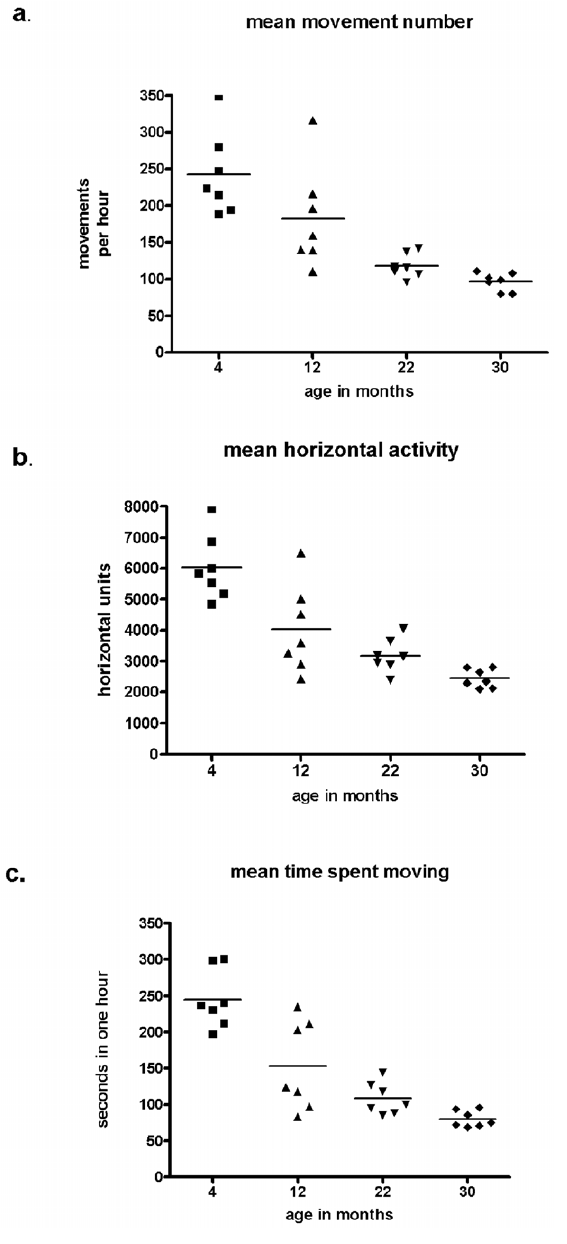
Figure 4. Longitudinal-characterization of locomotor activity during aging. Mean for the age tested represented by horizontal line and the locomotor activities of test subjects represented by points. The young group was tested at 4 and 12 months and the old group tested at 22 and 30 months. a. movement number (ANOVA, group p , 0.0001; post-hoc 12 vs. 30 mos, p , 0.05): aging difference within group, 4 vs. 12 mos., p , 0.05; 22 vs. 30 mos., p , 0.05 (Student’s paired t-test used for all within group comparisons). b. horizontal activity (ANOVA, group p , 0.0001; post-hoc 12 vs. 30 mos., p , 0.01): aging difference within group, 4 vs. 12 mos., p , 0.05; 22 vs. 30 mos., p , 0.05. c. time spent moving (ANOVA, group p , 0.0001; post-hoc 12 vs. 30 mos., p , 0.05): aging difference within group, 4 vs. 12 mos., p , 0.05; 22 vs. 30 mos., p , 0.05. Data not shown : total distance (ANOVA, group p , 0.0001; post-hoc 12 vs. 30 mos, p , 0.05): age difference within group, 4 vs. 12 mos., p , 0.05; 22 vs. 30 mos., p . 0.05, and movement velocity (ANOVA, group p , 0.005; post-hoc 12 vs. 30 mos., p . 0.05): aging difference within group, 4 vs. 12 mos., p , 0.05; 22 vs. 30 mos., p , 0.05.